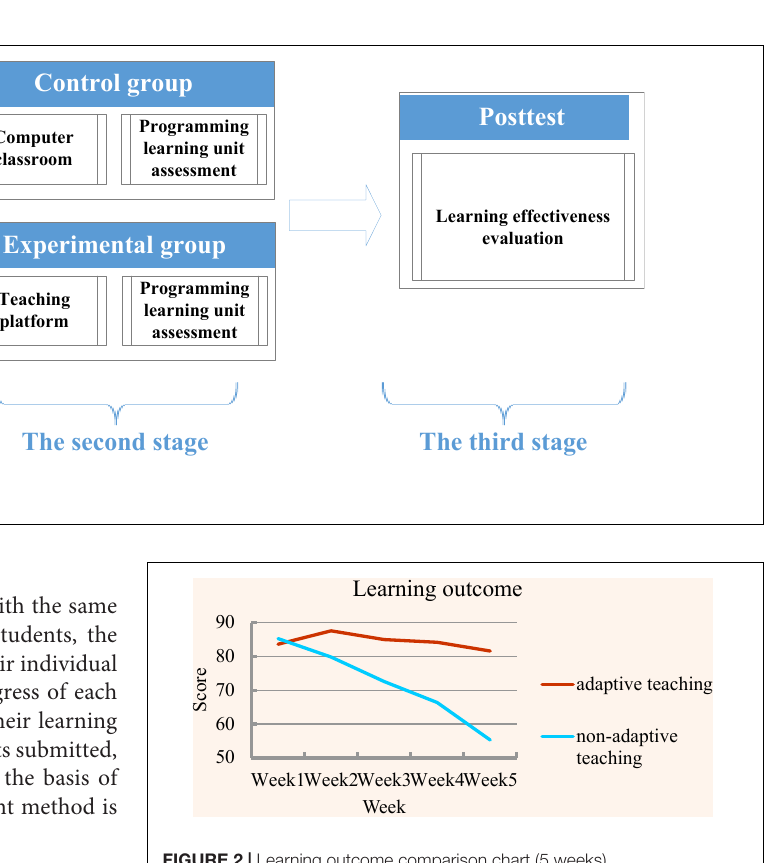
FIGURE 2 | Learning outcome comparison chart (5